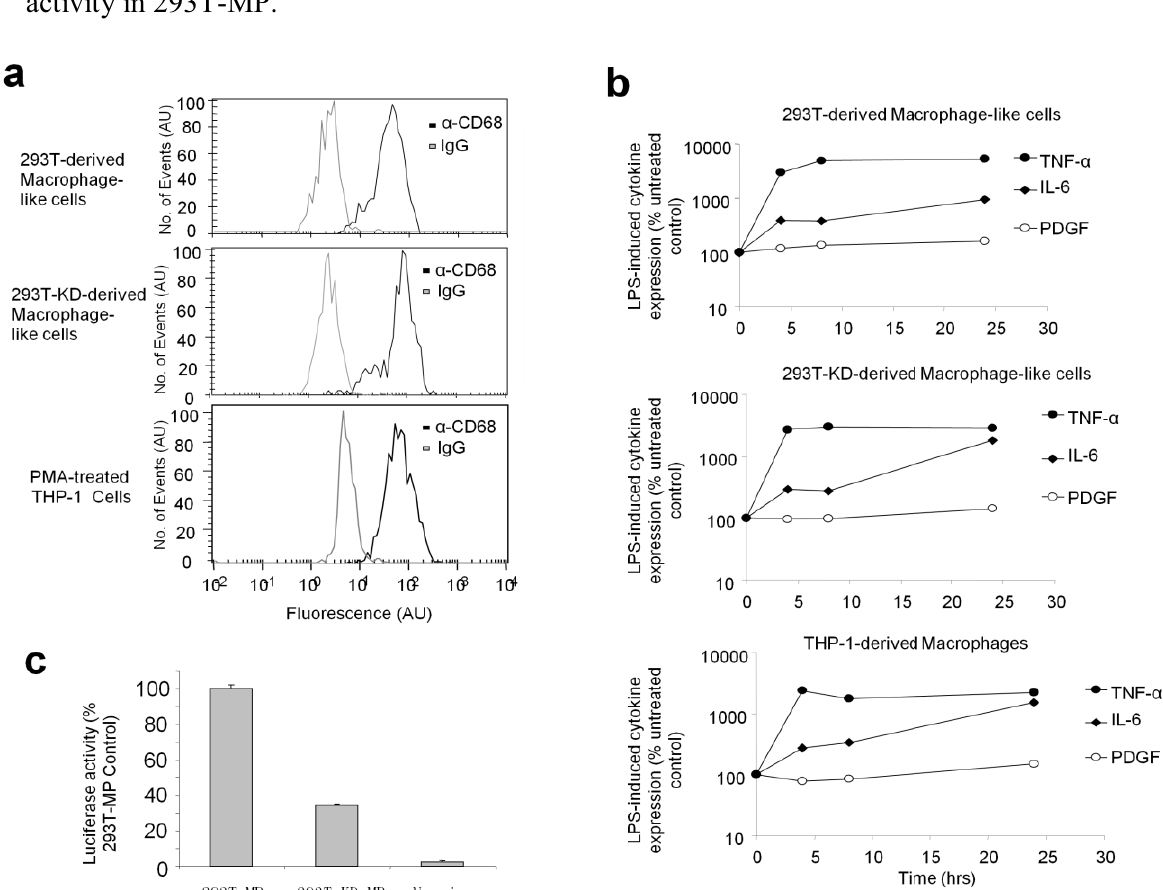
Figure 7. Characterization of iPSC-derived macrophages. ( a ) Analysis of CD68 expression in iPSC-derived macrophages. 293T iPSC-derived monocytes and 293T-5KD iPSC-derived monocytes were differentiated into macrophages by culturing with M-CSF. Control THP-1 cells were differentiated with PMA. The cells were stained with APC-linked antibodies against CD68 and analyzed by FACS. Solid line: the cells stained with antibodies; shadow line: cells stained with non-specific IgG. ( b ) Macrophages derived from 293T-iPSCs and 293T-KD-iPSCs produce cytokines in response to LPS stimulation. 293T and 293T-KD derived monocytes were differentiated into macrophages, and treated with LPS. Supernatant samples were collected prior to the LPS treatment and at 4, 8, and 24 hours of stimulation. Cytokines were analyzed by 10-plex Bio-Rad Multi-Plex assay. Induction of TNF- (cid:302)(cid:3)(cid:68)(cid:81)(cid:71)(cid:3)(cid:44)(cid:47) -6 and non-responsive PEDF are shown as percent of the initial concentration. ( c ) HIV-1 replication is reduced in macrophages differentiated from 293T-KD iPSC. Monocytes were differentiated into macrophages, infected with VSVG-HIV-1-Luc and cultured for 3 days. The cells were lysed and luciferase activity was measured. The activity was normalized to the cell number and presented as percent of activity in